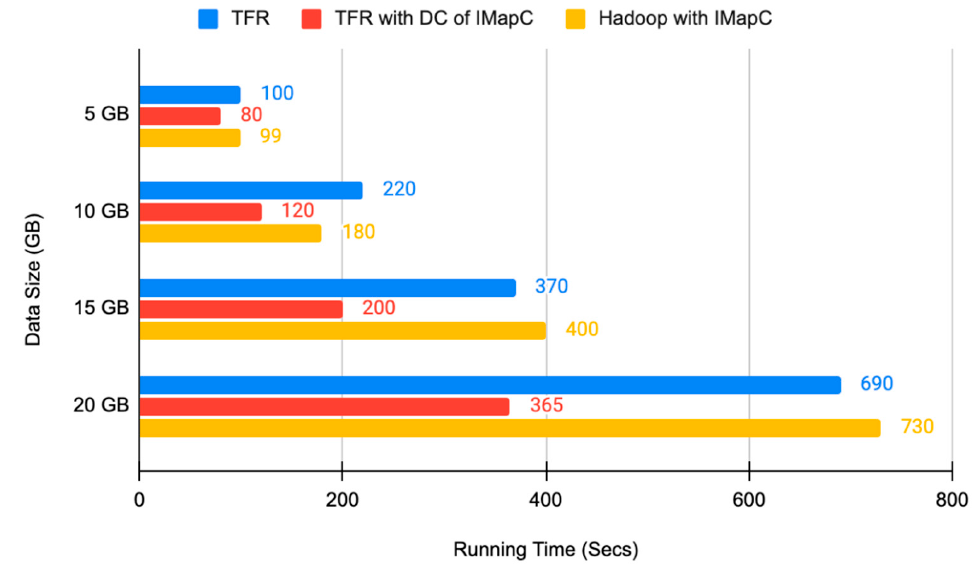
Figure 9. The execution time of the Sort program comparing TFR, TFR with IMapC, and Hadoop. Table 6. Performance Comparison of TFR, TFR with DC of IMapC, and Hadoop on running Word- Count program.